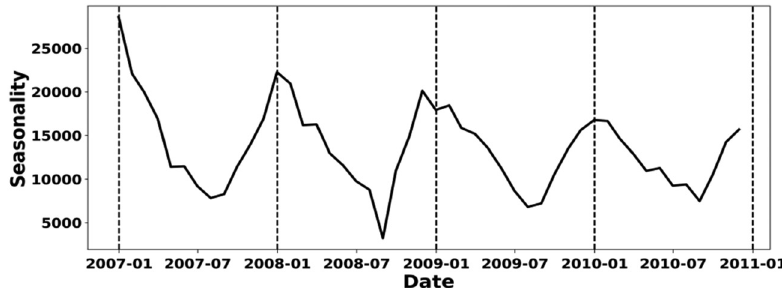
Figure 4: Seasonality of household electricity